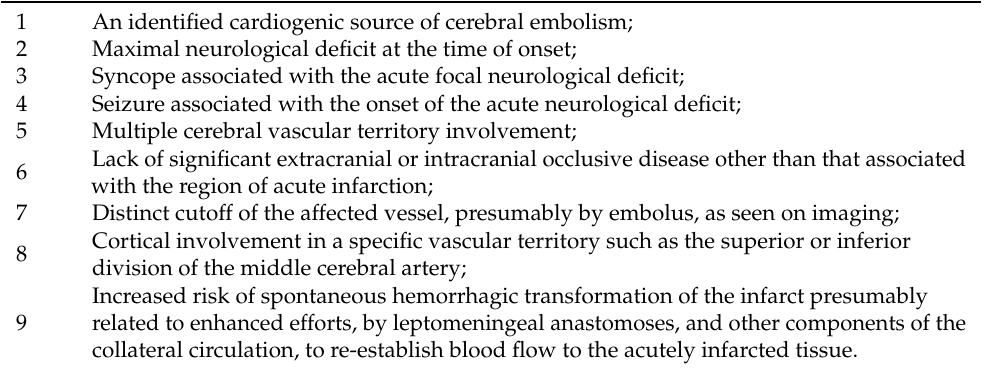
Table 1. Clinical and Radiological Features that Support Cardioembolic Stroke as the Potential